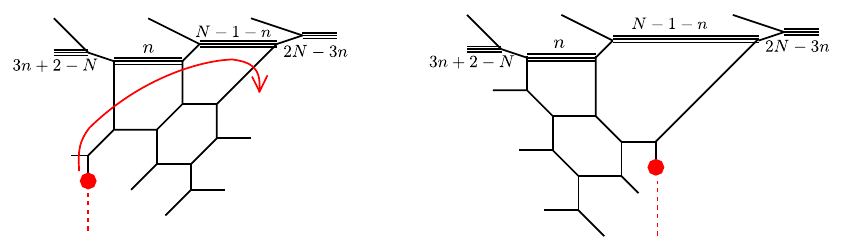
Figure 16 . Derivation of the distribution duality 2.